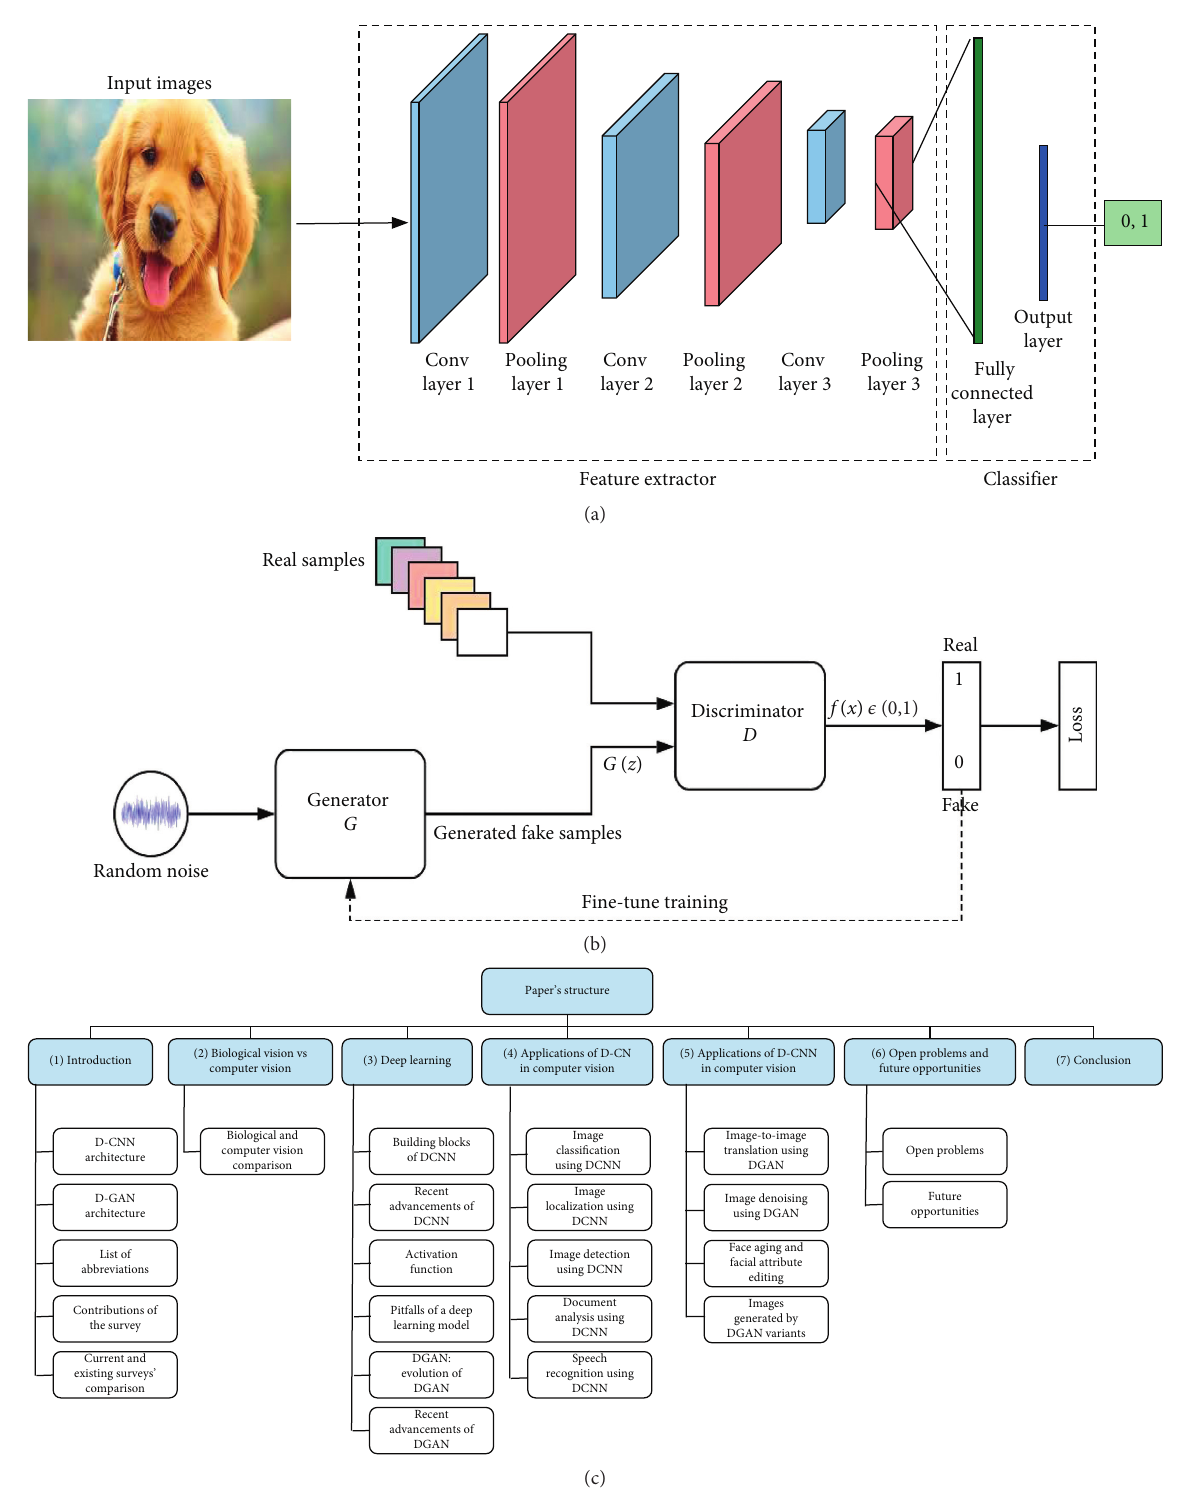
Figure 1: (a) The general architecture of deep CNN. (b) The architecture of deep generative adversarial networks. (c) Structure of this